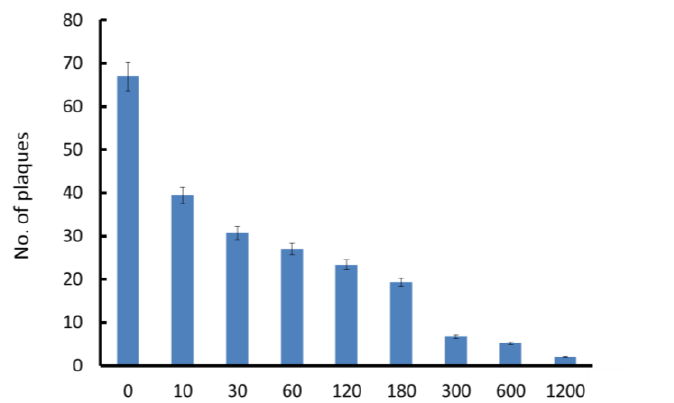
Figure 4. Effect of ultrasound exposure and delayed viral inoculation on HSV-1 RH2 plaque formation. SAS cells were exposed to ultrasound at first. After incubation at room temperature for 10 to 1200 s, cells were inoculated with 5 × 10 3 PFU of HSV-1 RH2 and then immediately washed with PBS to remove unbound virus and plaque formation was performed at 37 °C. Results are means (± SD) of three determinations.